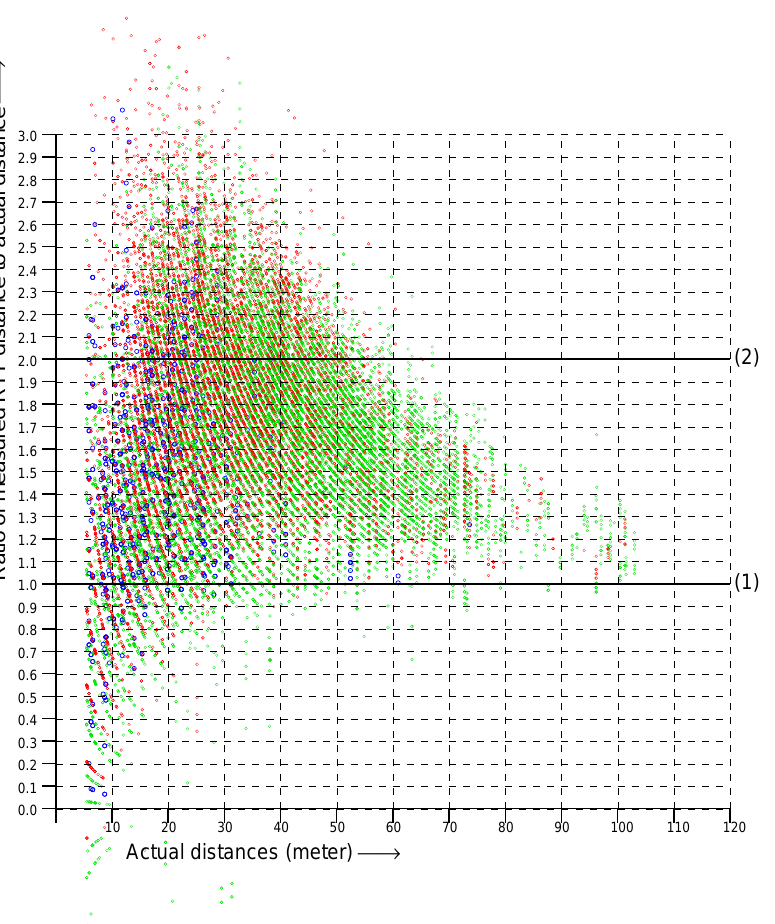
Figure 3. Scattergram of the ratio of RTT measurements to actual distance (vertical axis) versus actual distance (horizontal axis). (Green, measurements in the 2.4 GHz band; red, in the lower and upper 5 GHz band; blue, in the DFS part of the 5 GHz band). Solid lines mark ratios (1) and